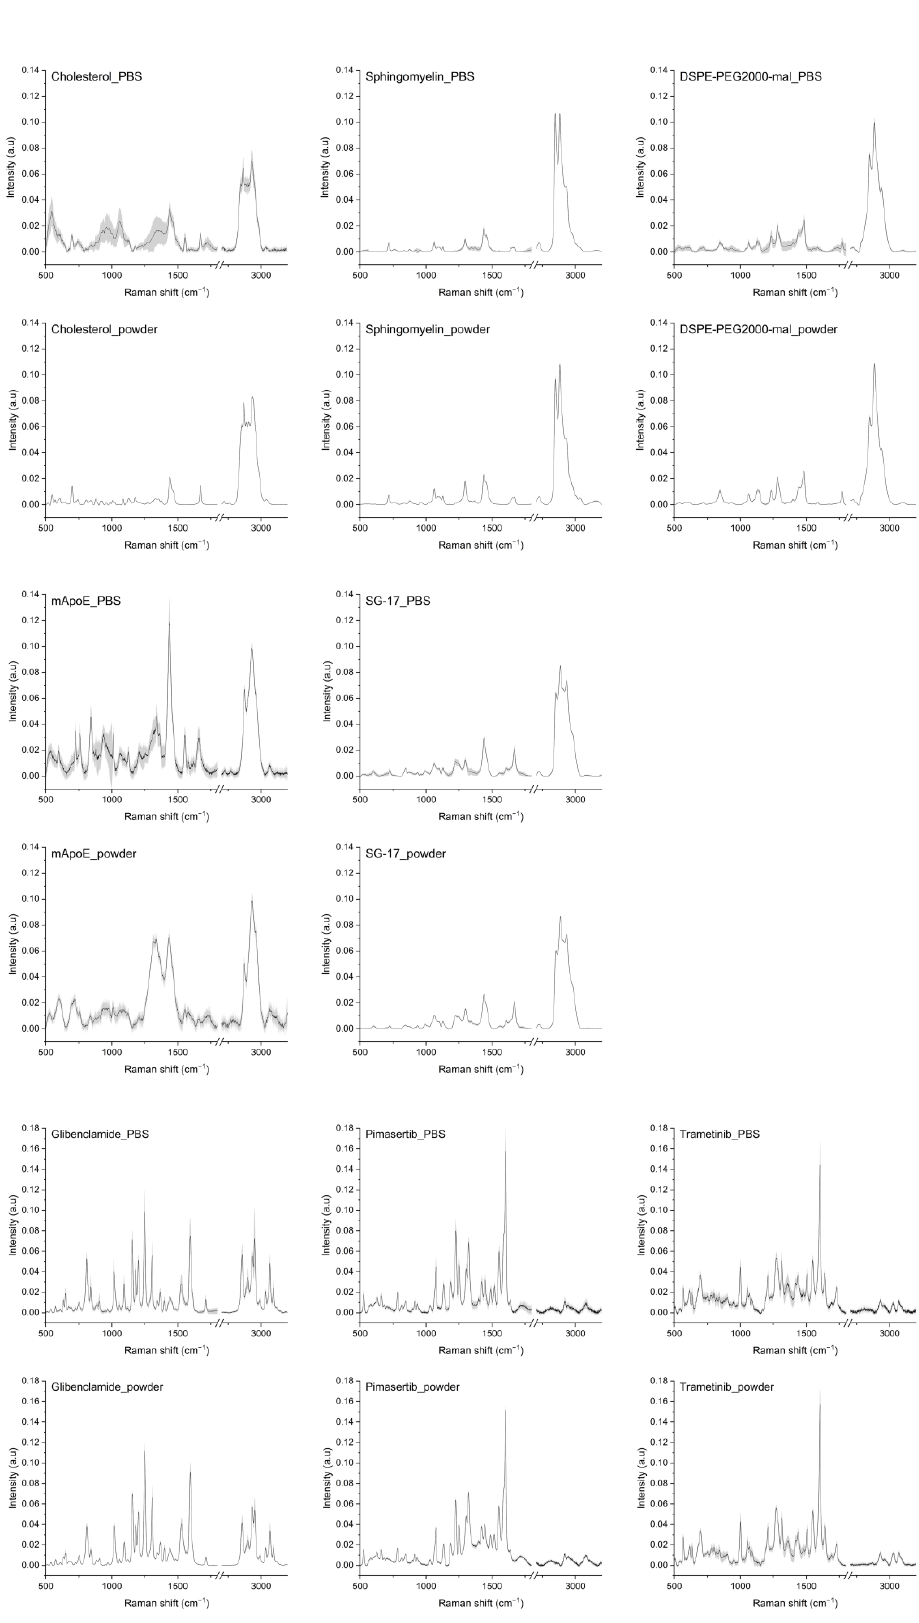
Figure 1. Raman spectra of LP components: cholesterol, sphingomyelin, DSPE-PEG2000-maleimide, mApoE, SG-17, glibenclamide, pimasertib and trametinib in PBS and in solid form (powder). The averages of Raman spectra are represented after baseline subtraction and normalization. Grey areas represent the standard